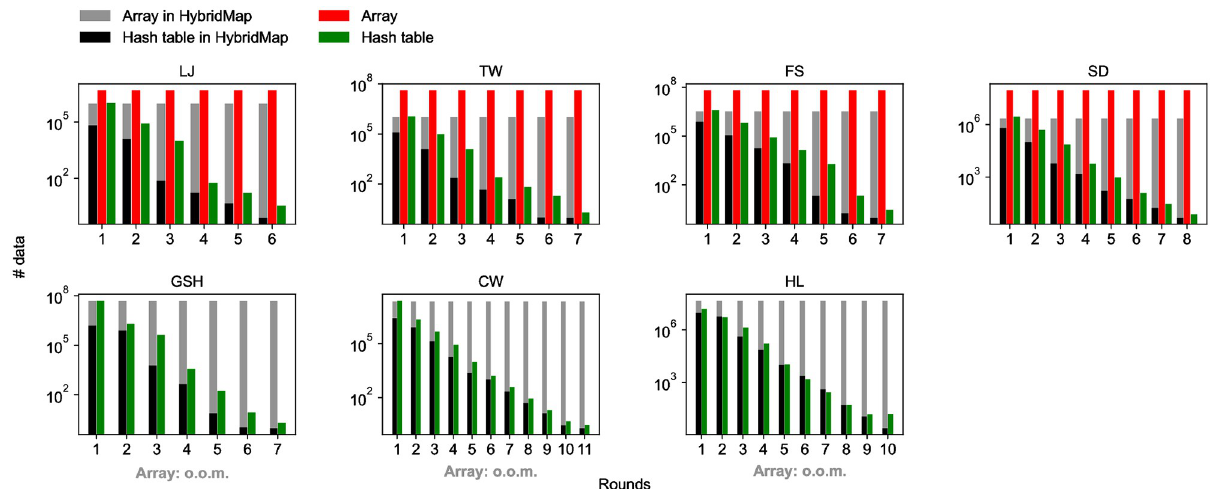
Fig 12. The numbers of data stored in HybridMap, a hash table, and an array each round of UniCon-opt. The Y-axis is in a log scale. HybridMap significantly reduces the data stored in memory compared to an array, letting UniCon-opt succeed in processing large graphs: GSH, CW, and HL. HybridMap and a hash table have no significant difference in terms of the peak number of stored data.